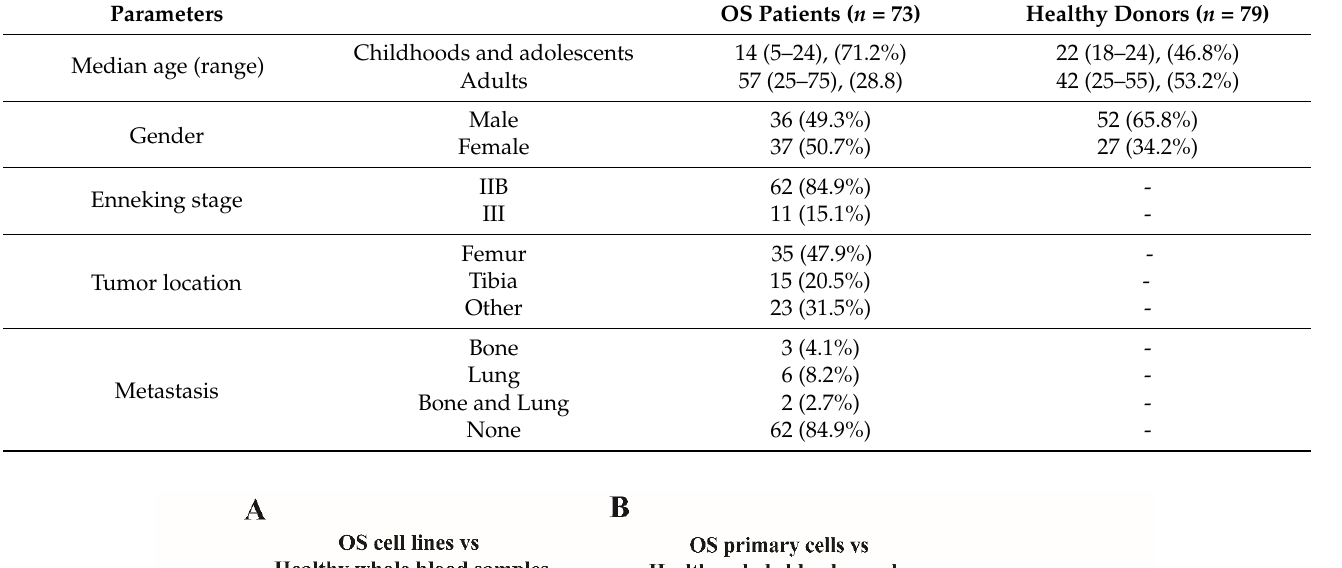
Table 2. Clinical characteristics of OS patients and healthy donors (buffy coat samples).